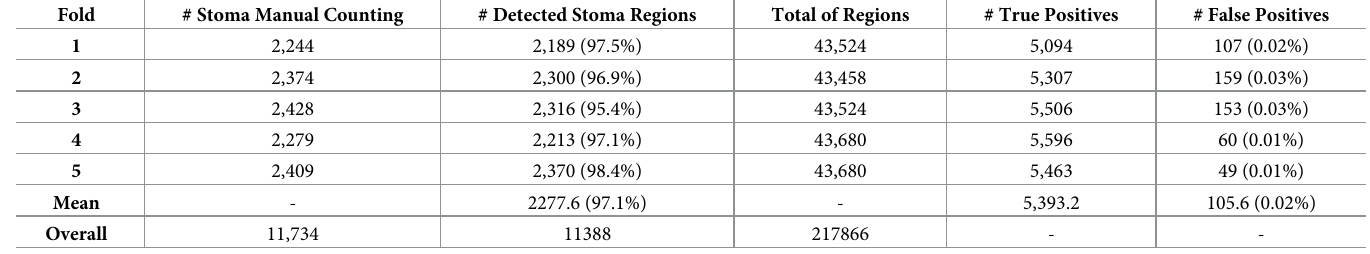
Table 3. Final effectiveness results obtained with the most promising strategy for stomata detection (Support Vector Machine—SVM combined with VGG16 convo- lutional neural network) based on a 5-fold cross-validation strategy. The performance evaluation considered the number (#) of stomata detected in relation to the real